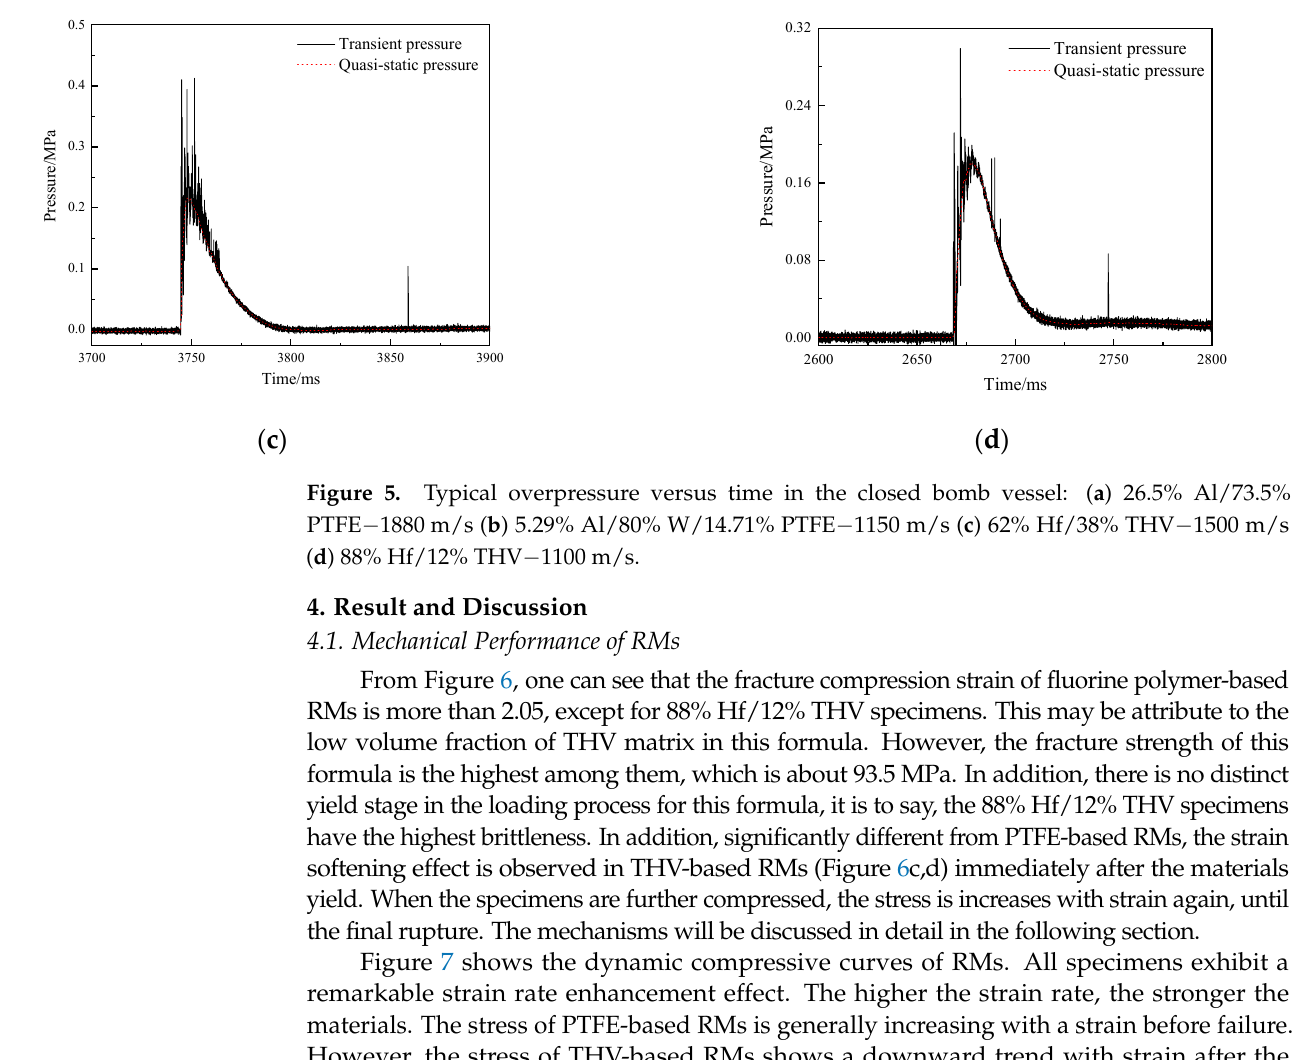
Figure 6. Quasi-static compressive performance curves of RMs: ( a ) 26.5% Al/73.5% PTFE ( b ) 5.29% Al/80% W/14.71% PTFE ( c ) 62% Hf/38% THV ( d ) 88% Hf/12% THV. Figure 7 shows the dynamic compressive curves of RMs. All specimens exhibit a re- markable strain rate enhancement effect. The higher the strain rate, the stronger the ma- terials. The stress of PTFE-based RMs is generally increasing with a strain before failure. However, the stress of THV-based RMs shows a downward trend with strain after the yield point, indicating that the THV-based RMs are strain-softening materials, whereas the PTFE-based RMs are strain-hardening materials.